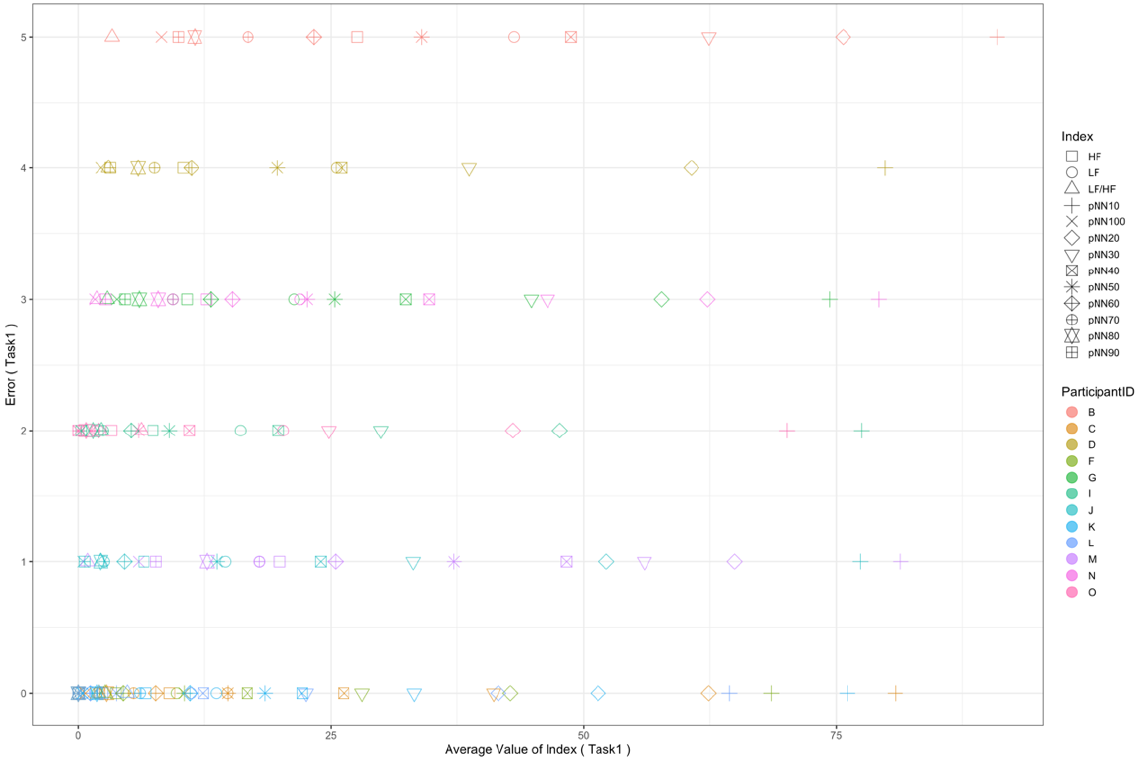
Figure 8. Scatterplot between the number of errors of Task1 vs. the HRV indexes during Task1.